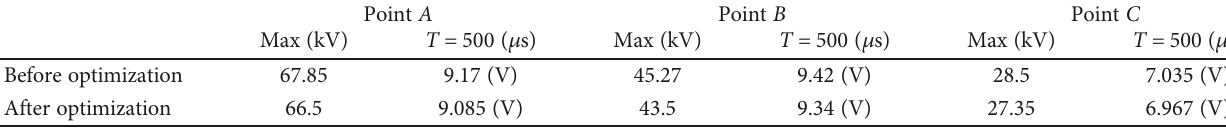
Table 1: Simulation data comparison before and after optimization in regular grounding grid.